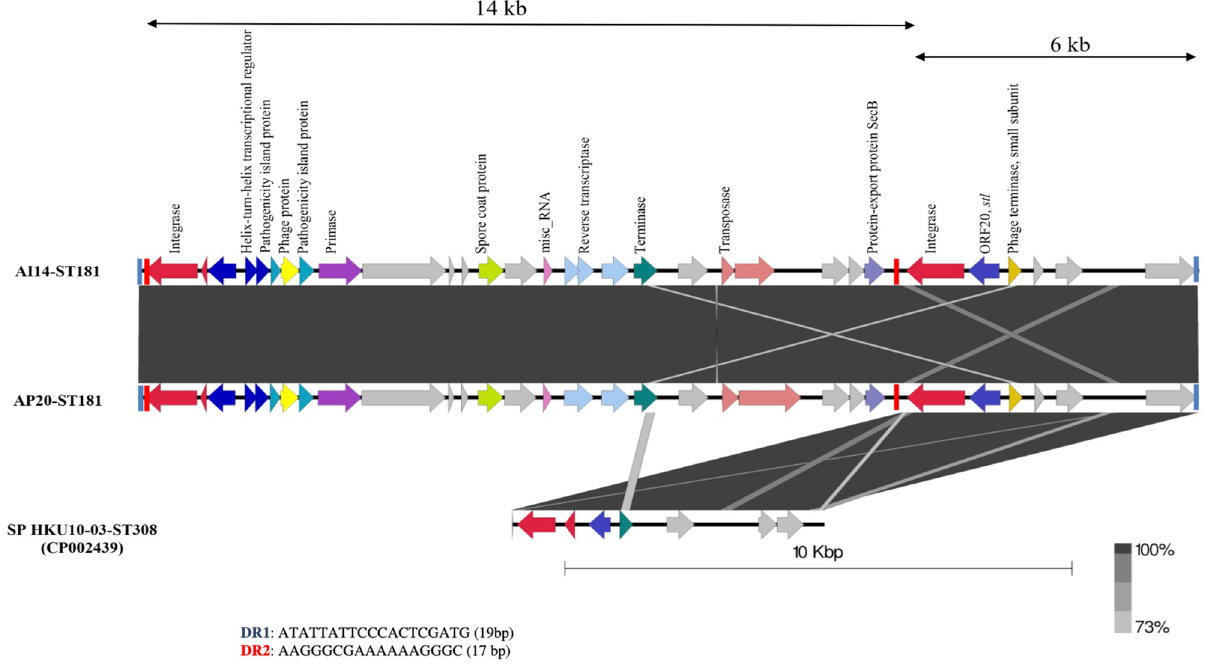
Fig 4. Structure of SpPI-181 in AI14-ST181 and AP20-ST181compared with the sequence of S . pseudintermedius HKU10-03-ST308. Hypothetical proteins and proteins with unknown function are represented in grey color. Figure was generated using Easyfig 2.1.